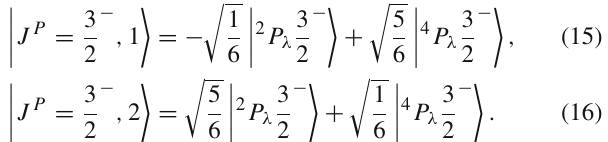
Fig. 1 Partial decay widths of the (cid:6) b K channel for the J P = 1 / 2 − , J P = 3 / 2 − and J P = 5 / 2 − (cid:2) b states as a function of the mass Table 4 Partial decay widths (MeV) of the 1 P states within the j - j couplingschemeinthe (cid:2) b family.Thevalueinsideofthebracesdenotes the reference mass (MeV) of the corresponding state